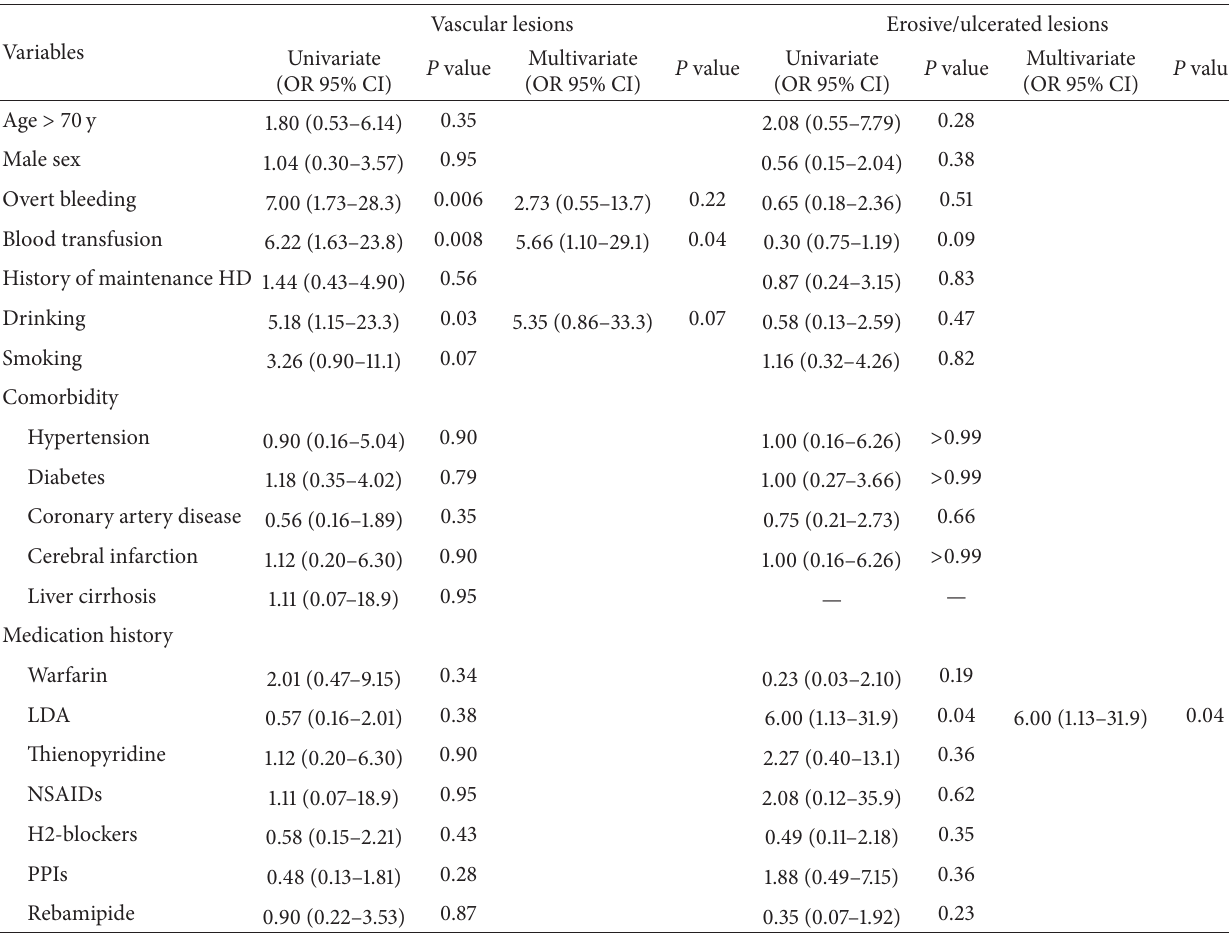
Table 4: Univariate and multivariate analyses to identify predictive factors for the presence of small bowel lesions in the CKD patients.